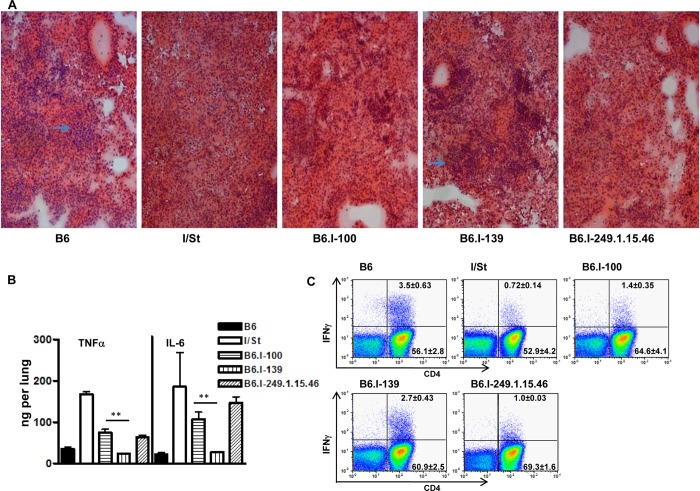
Possession of the H2-Ab1
j-like alleles results in a more severe TB infectious course.
A–Representative tuberculous lung lesions at day 35 post-infection. Hematoxylin and eosin staining, magnification x100. Arrows show granulomatous structures. B–TNF-α and IL-6 production in infected lungs at day 60 post-challenge. Whole-lung homogenates from individual mice (3 per group) were assessed in the ELISA format. The results are expressed as mean ± SD from two independent experiments (total N = 6), P < 0.05 for B6.I-100 and B6.I-139, ANOVA. C–The number of lung IFN-γ-producing CD4+ T cells was assessed by intracellular staining for IFN-γ at 35 days post-challenge. After culturing with mycobacterial sonicate, the lung cell population gated for CD3 expression was analyzed as displayed. Results of one of two similar experiments (total N = 6) are shown, with statistics for 3 individual mice per group provided in quadrants. In controls (cells from normal mice with mycobacterial sonicate, or cells from infected mice without antigen in culture) the per cent of IFN-γ-producing lung CD4+ T cells never exceed 0.1. P < 0.05 for B6.I-100 and B6.I-139, ANOVA.